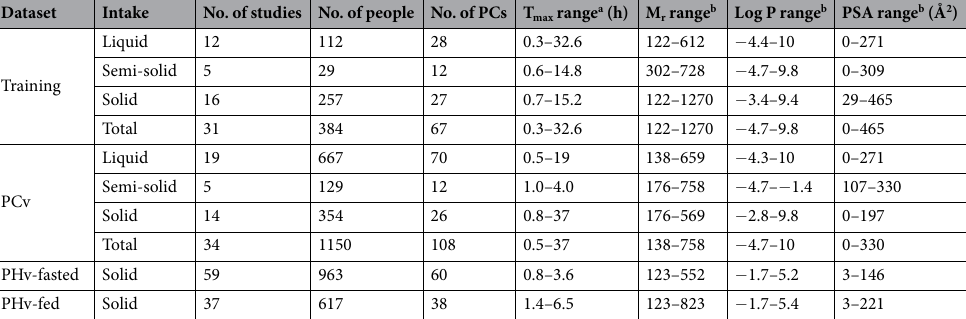
Table 3. Summary of datasets for development and validation of the predictive model. a T max of phytochemicals were collected from clinical studies in the literature. b Physicochemical properties of phytochemicals including M r , Log P and PSA were calculated using the Molinspiration Chemoinformatics